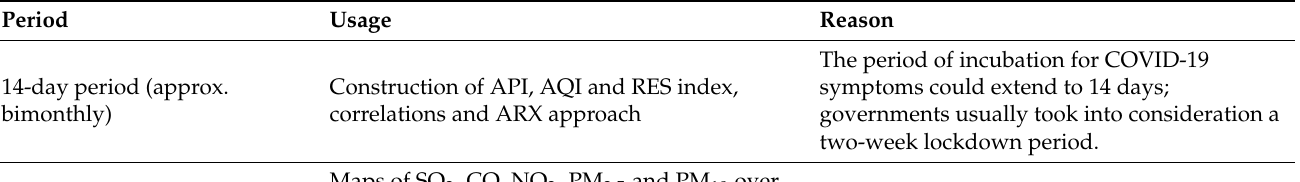
Table 2. Periods used in the